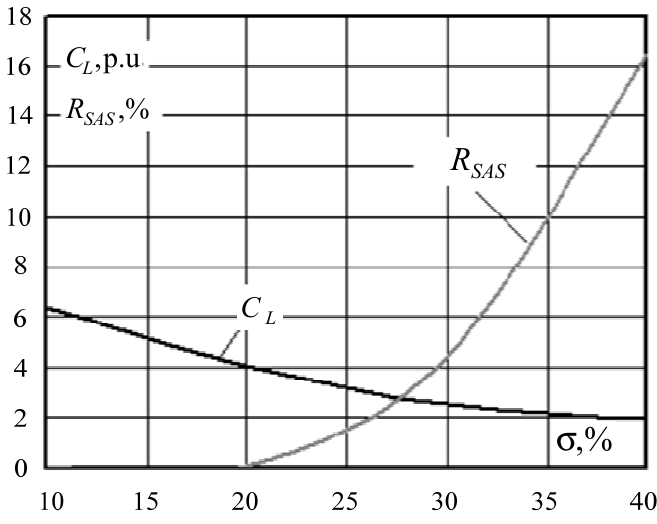
Figure 9. Dependence of the parameter L C in p.u. and the probability of the mode going beyond the SAS area on the standard deviation of the load capacities.